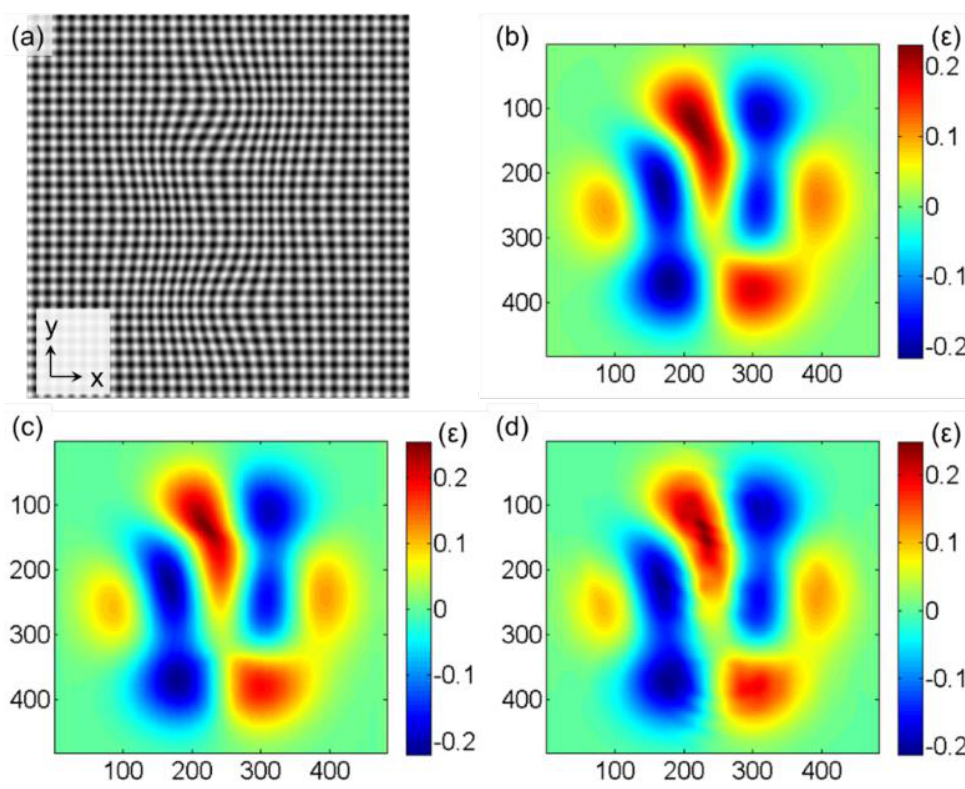
Figure 3. ( a ) Constructed lattice image containing deformation; Comparison results of εxx ( b ) by presetting; ( c ) by improved S − GPA; and ( d ) by G − GPA. presetting; ( c ) by improved S − GPA; and ( d ) by G −